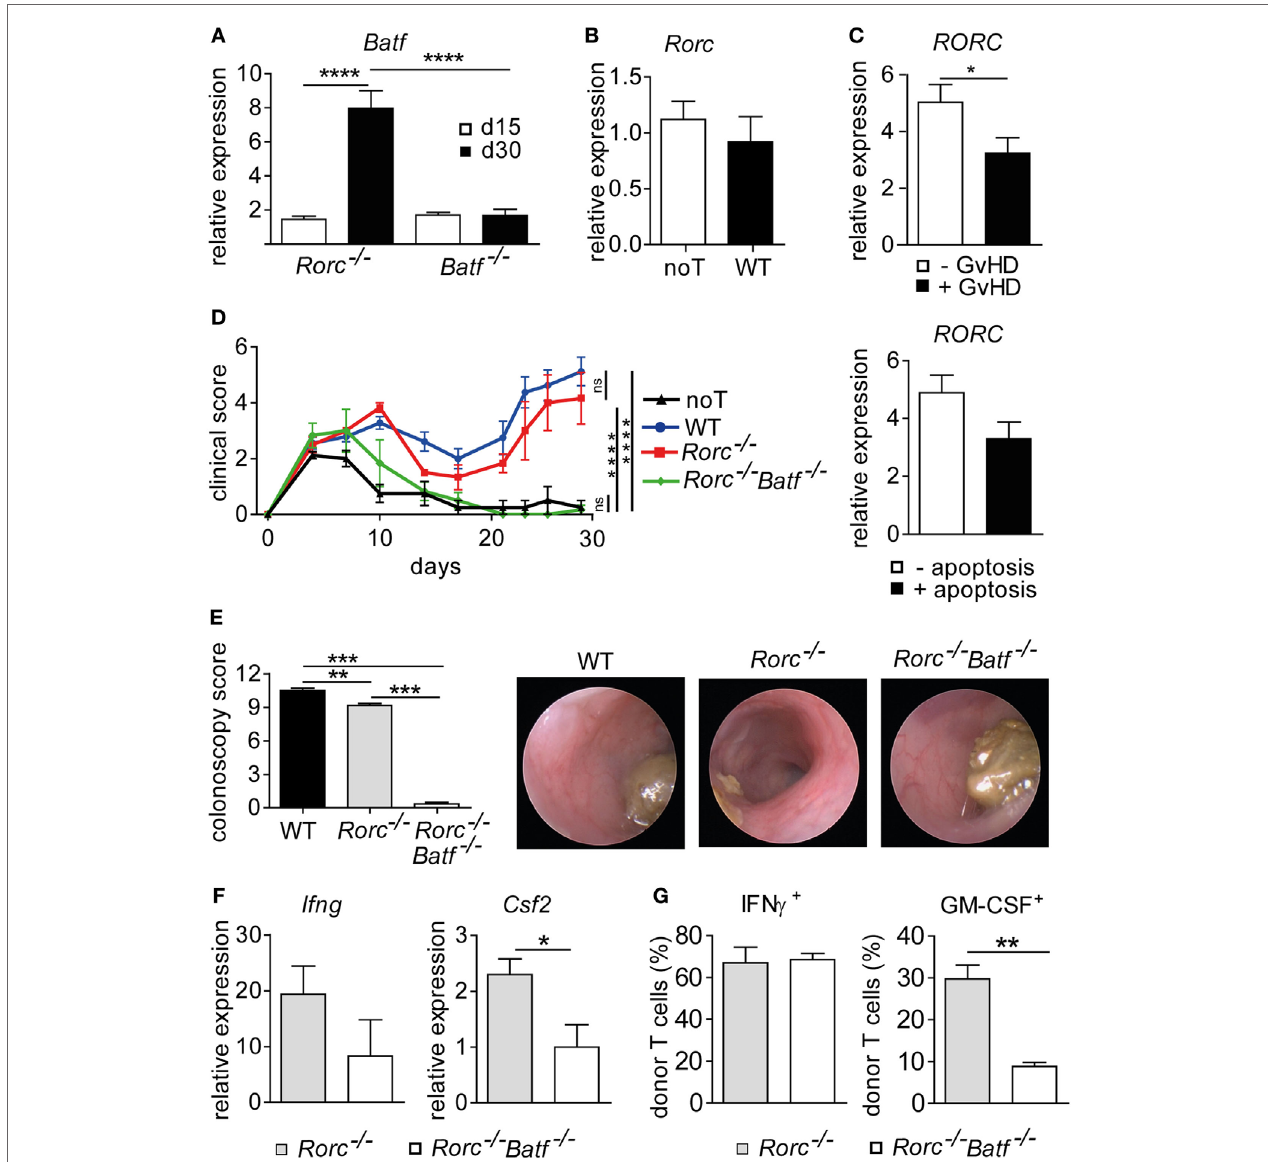
FigUre 5 | Retinoic acid-related orphan receptor gamma t-independent intestinal graft-versus-host disease (GvHD) is controlled by basic leucine zipper transcription factor ATF-like (BATF). (a) Transcript levels of Batf in colonic tissue of allo-HSCT BALB/c mice with severe signs of intestinal GvHD following transplantation of allogeneic CD3 + T cells derived from of Batf − / − and Rorc − / − mice were measured by quantitative real-time PCR (qPCR) at day 15 ( Batf − / − n = 12; Rorc − / − n = 2) and day 30 ( Batf − / − n = 12; Rorc − / − n = 4). Data represent pooled data from two independent experiments. Gene expression levels detected in colonic tissues of no T cells (noT) controls at day 15 were arbitrarily set down to 1 and all other gene expression levels were normalized to the expression level detected within noT controls. (B) Transcript levels of Rorc in colonic tissue of irradiated BALB/c mice transplanted with T cell depleted bone marrow alone (noT, n = 11) or followed by injection of allogeneic CD3 + T cells of wild-type (WT) ( n = 12) mice were measured by qPCR at day 30. (c) Transcript levels of RORC in colonic tissue biopsies from allo-HCT patients were measured by qPCR. Samples were grouped into indicated categories based on the absence ( − GvHD; n = 30) or presence ( + GvHD; n = 22) of GvHD-associated histopathological lesions or by the absence ( − apoptosis; n = 32) or presence ( + apoptosis; n = 20) of GvHD-related epithelial cell apoptosis. Data are shown as normalized relative RORC expression levels calculated from a standard curve. (D–g) Experimental GvHD induction was achieved as described in Figures 1 and 2 . To this end, allogeneic hematopoietic stem cell transplantation BALB/c mice were transplanted with allogeneic CD3 + T cells derived from WT ( n = 4), Rorc − / − ( n = 3), or Rorc − / − Batf − / − ( n = 3) mice or received no T cells (noT) as a control ( n = 4). (D) Mice were assessed three times a week for signs and severity of systemic GvHD. Data were analyzed by two-way ANOVA testing followed by Bonferroni’s multiple comparisons posttest. **** p < 0.0001 was considered significant, whereas p > 0.05 indicates no significance (ns). (e) At day 28, colitis severity was determined by colonoscopy and representative endoscopic images are shown. (F) Expression levels of Ifng and Csf2 transcripts within colonic tissues of Rorc − / − ( n = 7) or Rorc − / − Batf − / − ( n = 3) T cell receiving mice were analyzed by qPCR. Data are shown from at least one experiment. (g) Colonic lamina propria mononuclear cells of indicated donor T cell receiving mice were isolated and the frequencies of granulocyte-macrophage colony-stimulating factor (GM-CSF + ) or IFN γ + CD4 + donor T cells were assessed by flow cytometry employing intracellular cytokine staining techniques. Data of panels (a,e) were analyzed by one-way ANOVA followed by Bonferroni’s multiple comparisons posttest. ** p < 0.01, *** p < 0.001, and **** p < 0.0001 was considered significant. Data of panels (B,c,F,g) were analyzed by Student’s t -test. * p < 0.05 and ** p < 0.01 was considered significant. All data are shown as mean ±